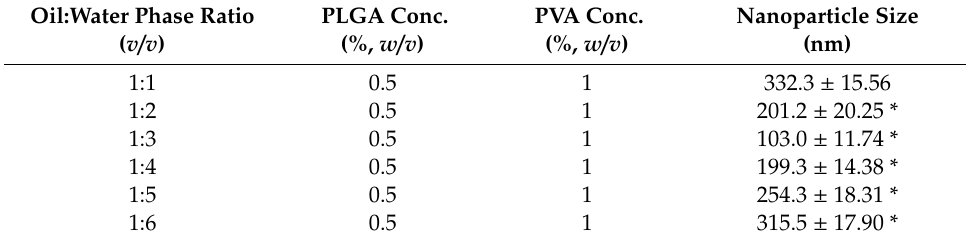
Table 3. E ff ect of oil–water phase volume ratio on mean particle size ( n = 5, mean ± SD).